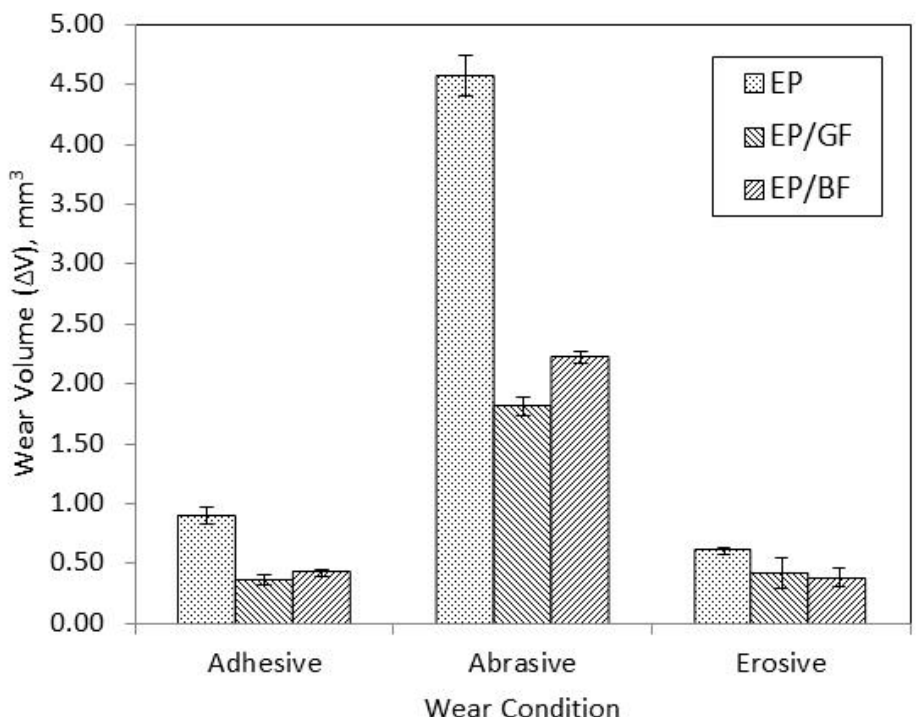
Figure 1. Wear volumes of pure epoxy and its composites at different wear conditions.